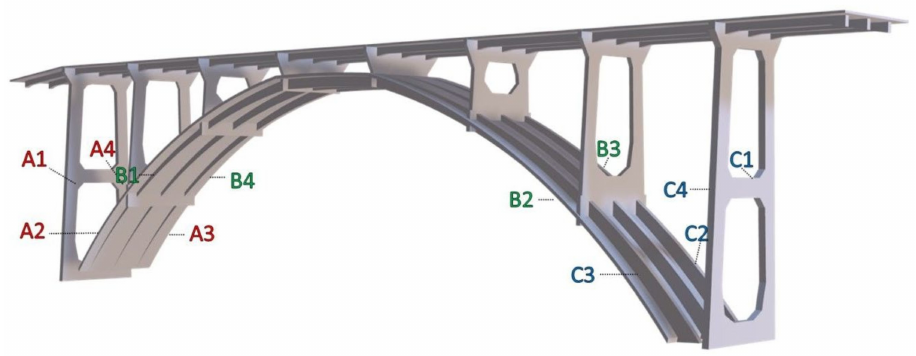
Figure 5. The layout of the vibrating wire extensometers system installed on the bridge.